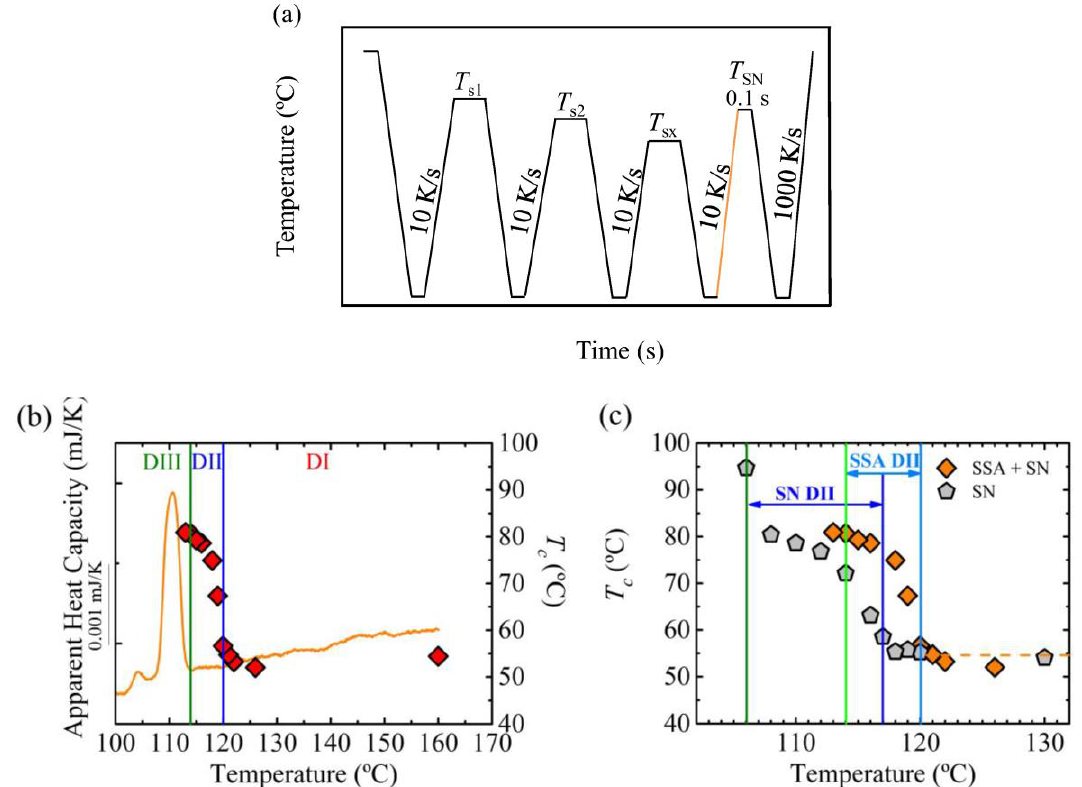
Figure 9. ( a ) SSA thermal procedure applied followed by SN, in order to erase the thermal history, the sample is kept at 160 ◦ C for 30 s and then it is cooled down to − 50 ◦ C, the sample is kept at this temperature, − 50 ◦ C, for 0.1 s, the sample is kept at the T s temperature for 0.1 s; ( b ) DSC heating scan (in orange color) of the sample submitted to SSA followed by SN and the corresponding crystallization temperature as a function of T s temperature and ( c ) crystallization temperature of the sample submitted to standard SN and the sample submitted to SSA followed by the SN procedure as a function of the self-nucleation temperature. Vertical lines correspond to the transition temperatures between Domains .